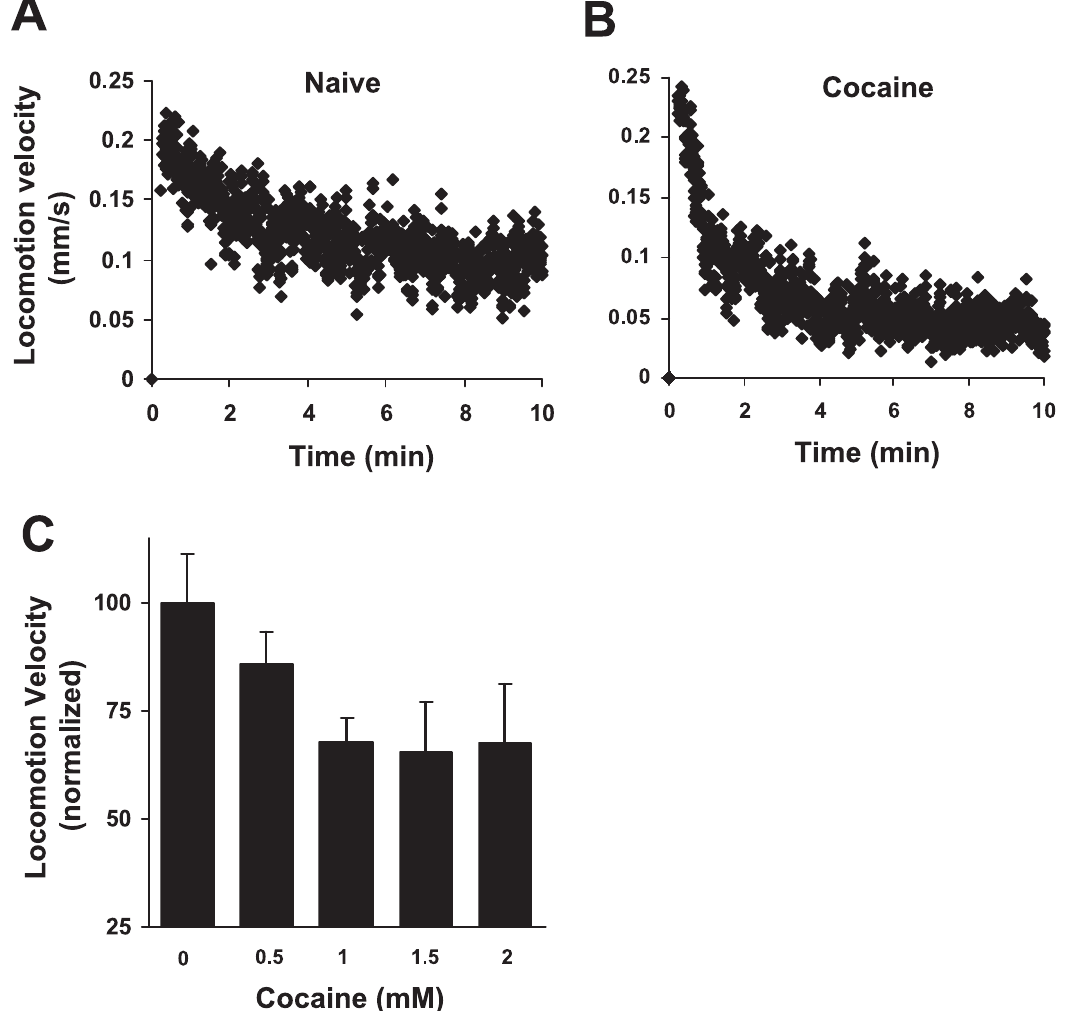
Figure 1. Cocaine induces a hypolocomotor response in C.elegans . (A–B) Worms were tracked on plates without cocaine (A) or with 1.5 mM cocaine. Shown are traces averaged from 10 worms. (C) Worms respond to cocaine in a dose-dependent manner. 10 worms were assayed for each concentration. Error bars: SEM.